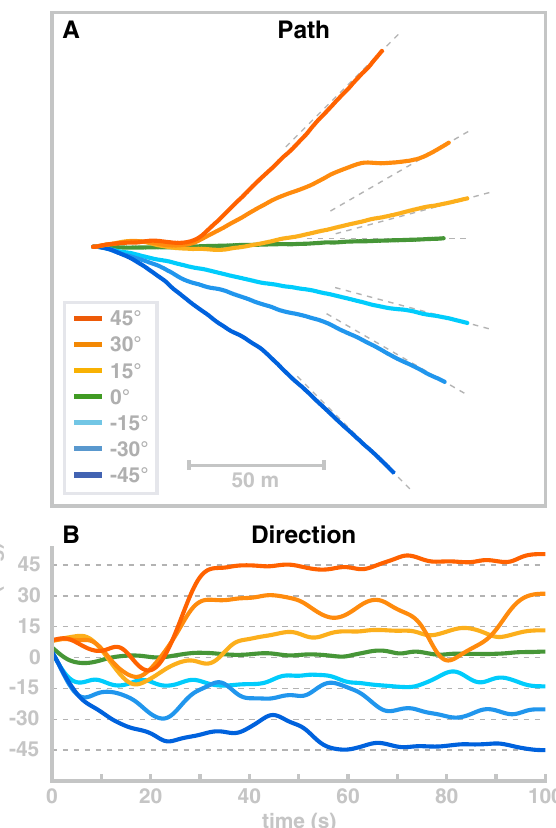
Figure 8. Direction control. Movement direction was adjusted by temporarily adding a constant offset value to the hip roll target angle until the target movement direction was reached, with seven different target directions. Panel ( A ) shows the horizontal path of the trunk center. Panel ( B ) shows the trunk orientation over